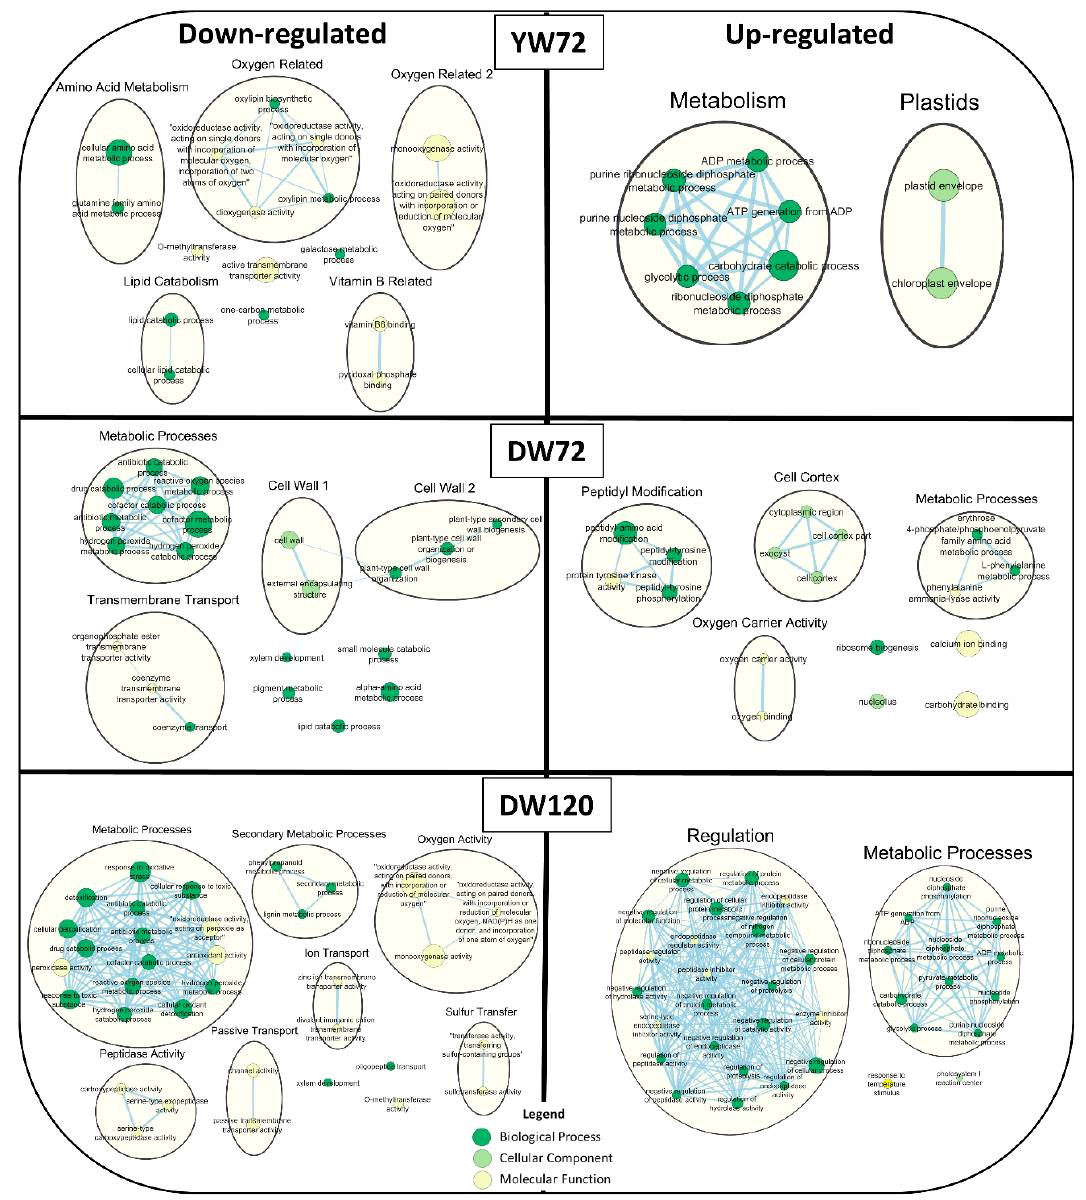
Figure 4. Summary of enriched Gene Ontology (GO) terms of down-regulated (left side) and up-regulated (right side) genes in waterlogged roots of Yerong at 72 h (YW72), as well as Deder2 under waterlogging stress at 72 h (DW72) and 120 h (DW120). Circle size represents number of genes in the GO term, and connections among circles represent overlapping gene sets of each GO term. Larger clusters are generally named based on contained GO terms. GO terms containing more than 500 genes were removed.